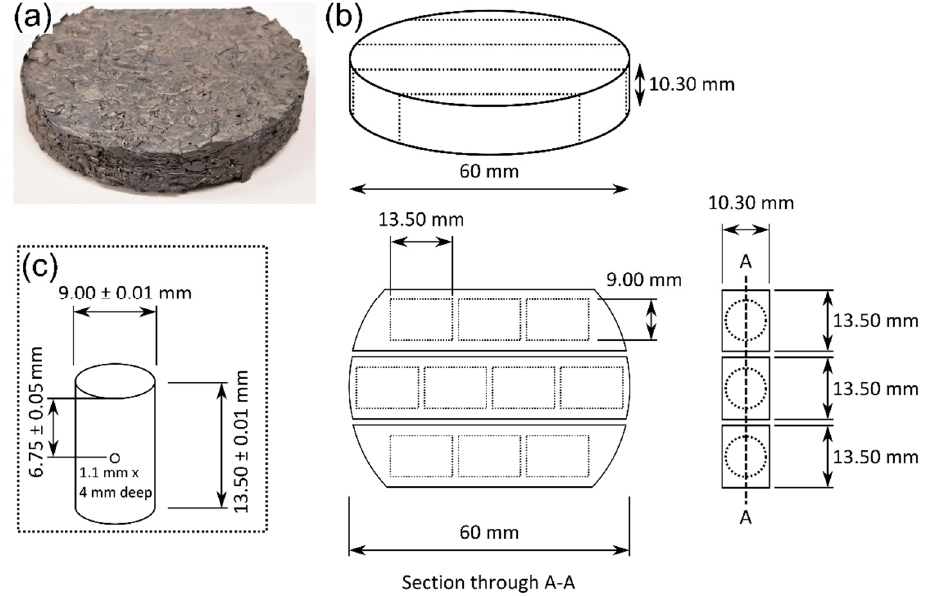
Figure 3. ( a ) Photograph of the 60 mm diameter disc of Ti-6Al-4V swarf consolidated via FAST at 1200 °C and 20 MPa for 30 min; ( b ) Schematic showing the dimensions of the FAST disc, where it was sectioned, and the location and orientation the test specimens were extracted from; ( c ) Schematic showing the dimensions of the cylindrical axisymmetric hot compression test specimens.